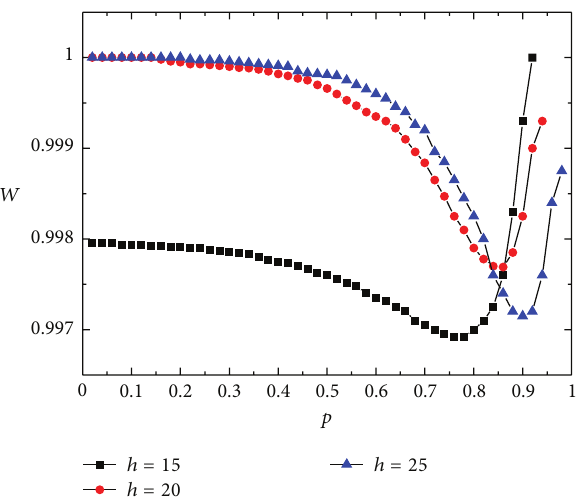
Figure 2: The defects stabilize on the cylinder axis at the position where the free energy density is minimal. Here the free energy density 𝑊 at the relative position 𝑝 on the axis of the capillary for three different cylinder lengths ℎ is shown. The meniscus curvature a = 2,0 is held constant.